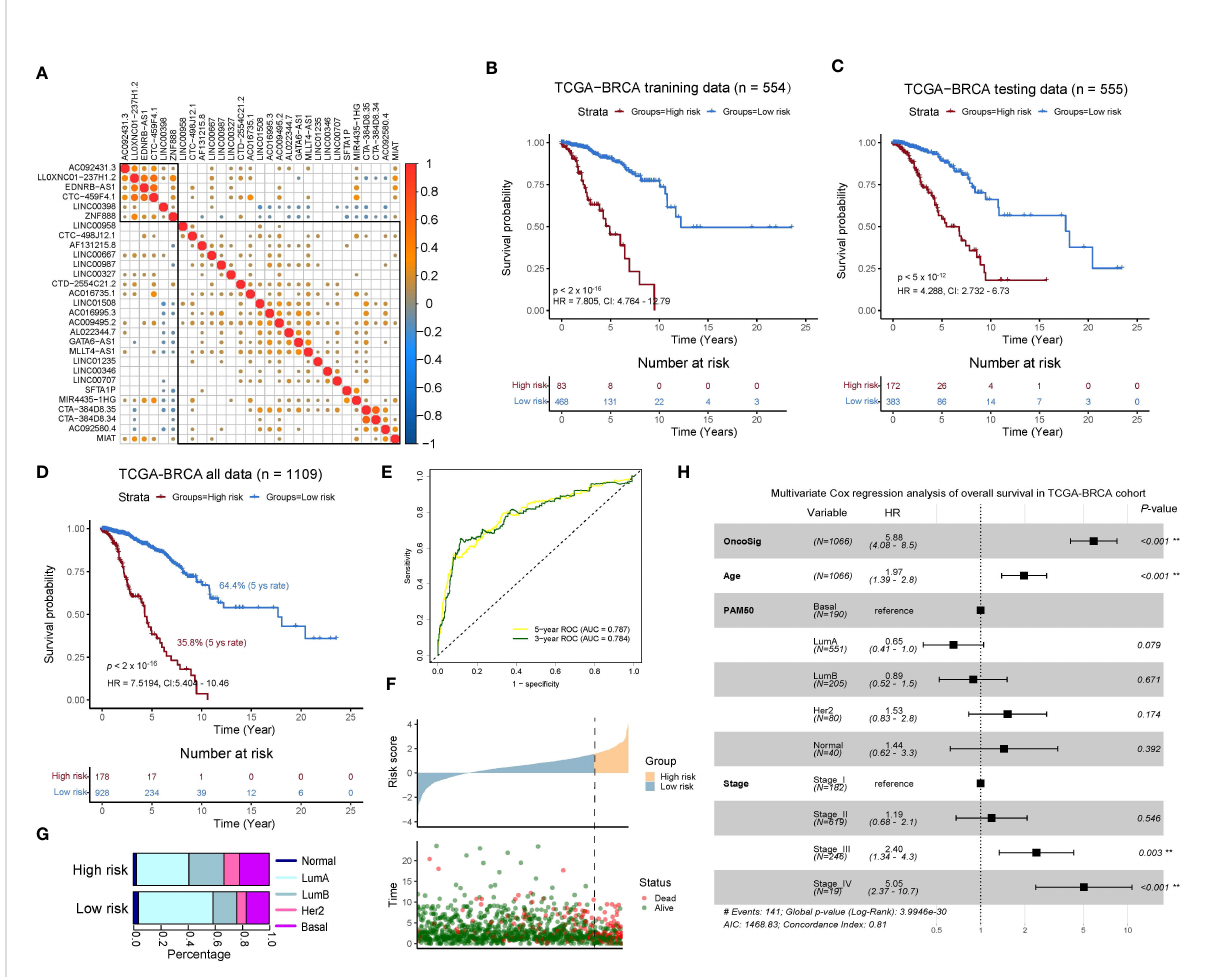
FIGURE 3 Development and validation of an oncogenic signaling pathway – derived lncRNA signature for outcome prediction in the TCGA-BRCA cohort. (A) Pearson correlation analysis for 29 lncRNA expressions divided into two submodules based on hierarchical clustering. (B – D) Kaplan – Meier (KM) survival analysis for the overall survival (OS) curves of BC patients in training (B) , testing (C) , and the total set. (E) Time-dependent receiver operating characteristic ( ROC ) curve at 3 and 5 years of OS. (F) High- and low-risk groups depicted by the OncoSig, ordered according to their scores, presenting the corresponding survival status for the BC patients. (G) Composition of patients with the PAM50 subtype in the two groups. (H) A multivariate analysis of the OncoSig, age, PAM50, and stage with OS in the TCGA-BRCA